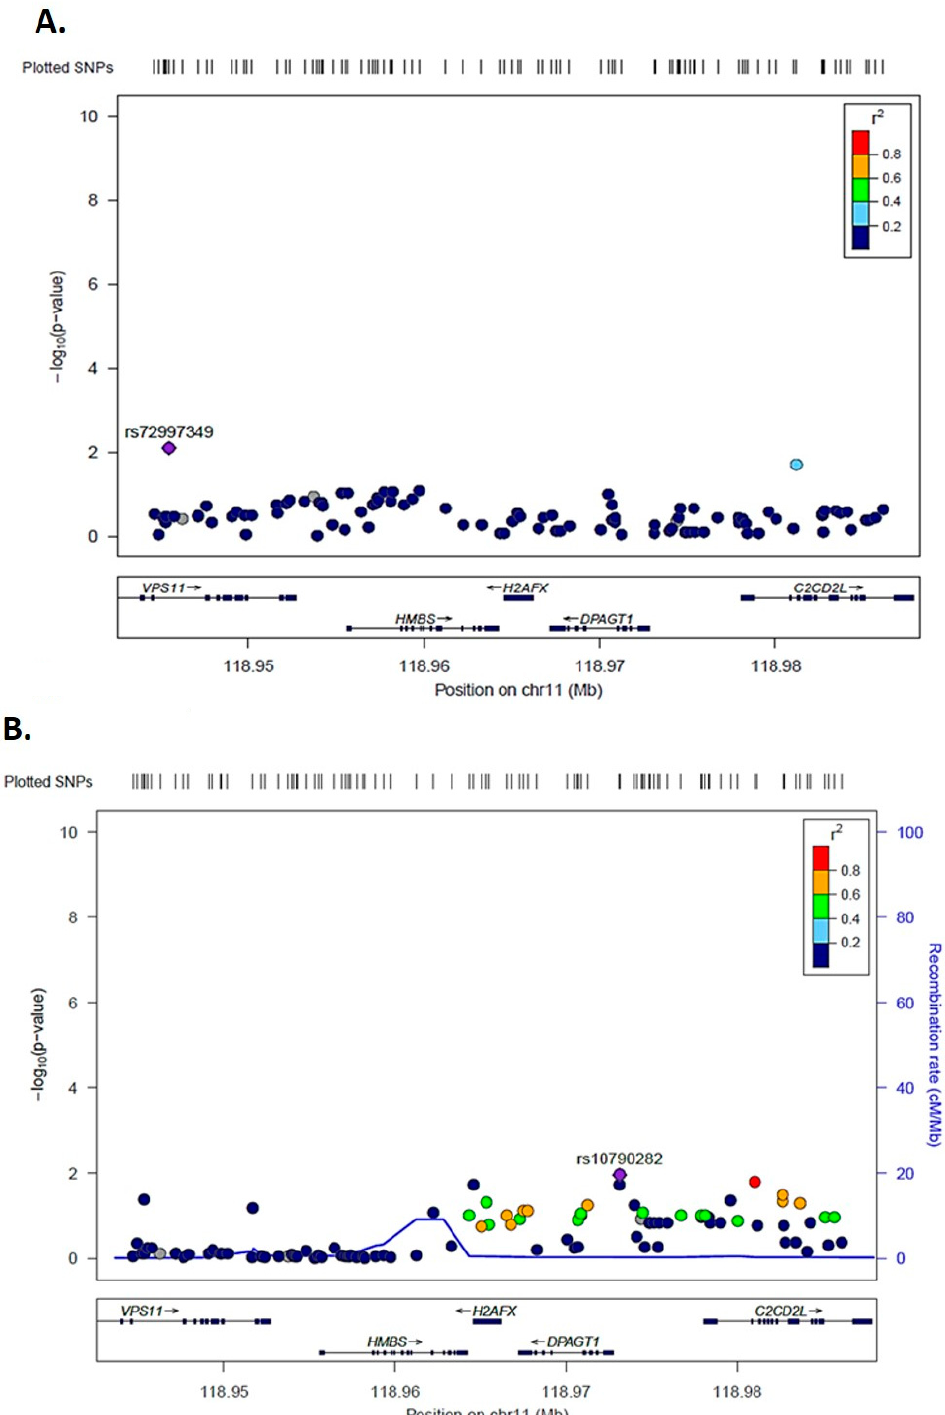
Figure 8. Polymorphism association analysis for H2AX. Reference SNP cluster rs72997349 (C-T) demonstrated a significant increase of risk for ovarian cancer ( A ), whereas Reference SNP cluster rs1079082 (A-G) demonstrated a significant increase in overall survival ( B